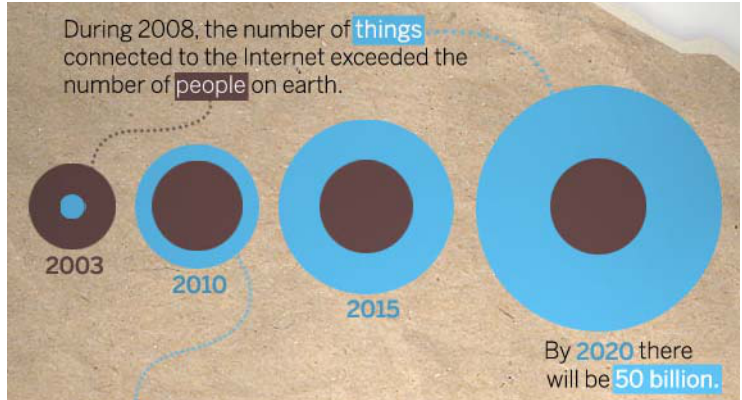
Figure 1. The accelerated growth of Internet-connected devices [7].